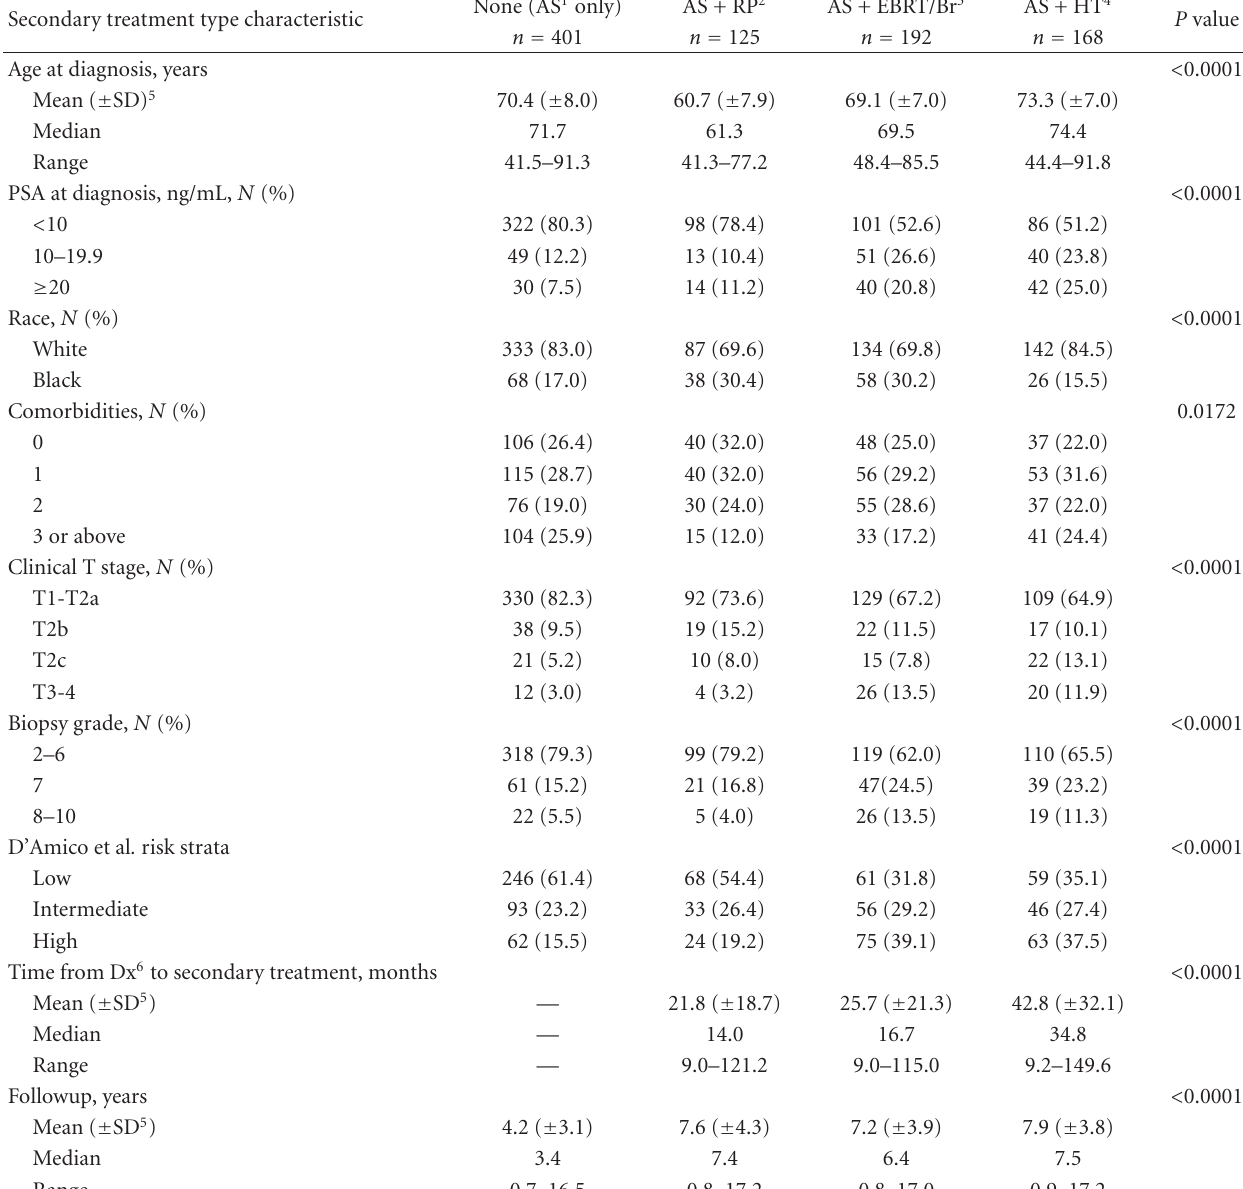
Table 2: Characteristics of subjects with prostate cancer (CaP) followed on active surveillance (AS) for primary treatment, stratified by secondary treatment type ( N =